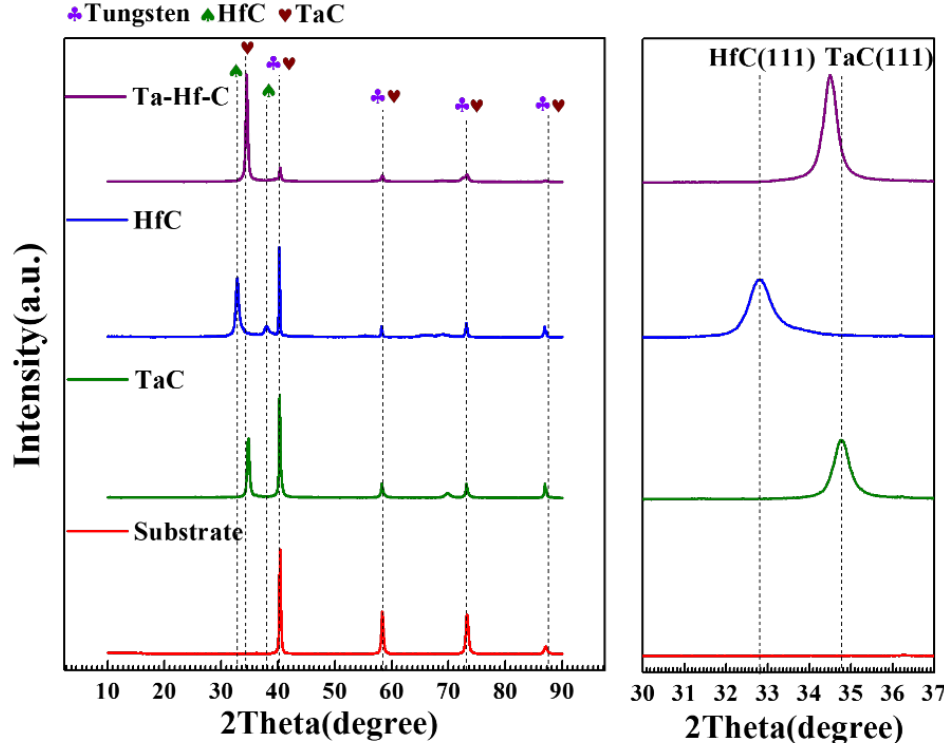
Figure 9. XRD patterns of TaC, HfC, Ta-Hf-C coatings, and the tungsten substrate. The inset shows the magnifications of the peaks in the 30 – 37° range.